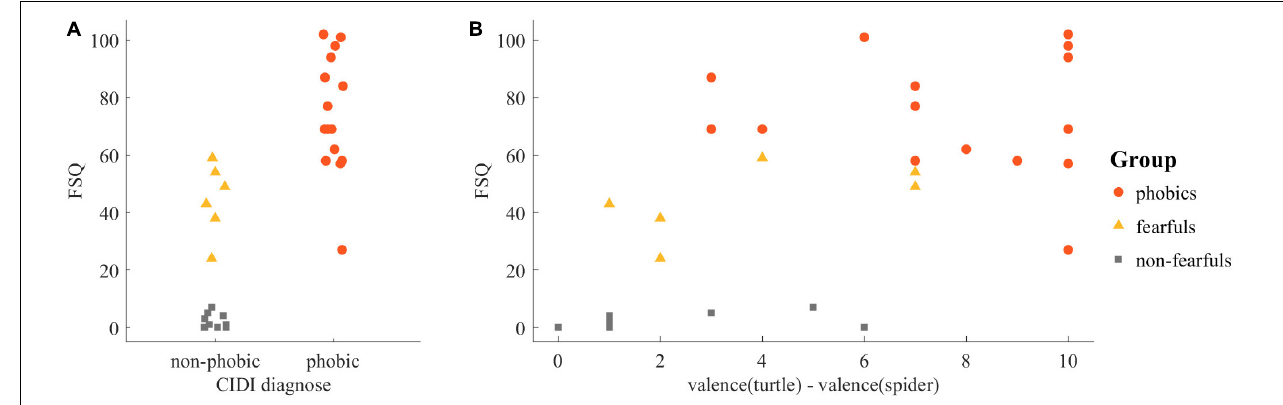
FIGURE 2 | Sample description: (A) Diagnosis for spider phobia of the Composite International Diagnostic Interview in association with the Fear of Spiders Questionnaire (FSQ) yielded three clusters that formed the basis for the groups. (B) The difference in the valence rating of the turtle and the valence rating of the spider in association with the FSQ.